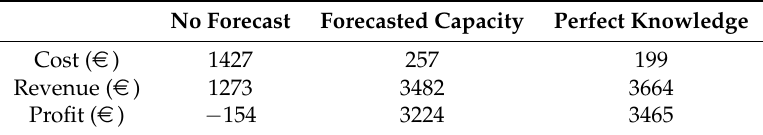
Table 3. Cost and profits of VPP while trading on the imbalance market for one